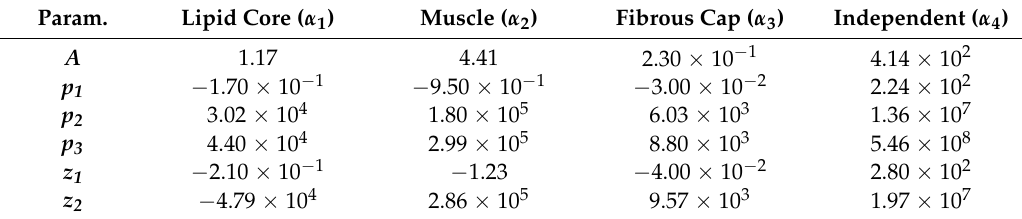
Table 4. Coefficients for Equation (9) in configurations with neo-atherosclerosis. Param.